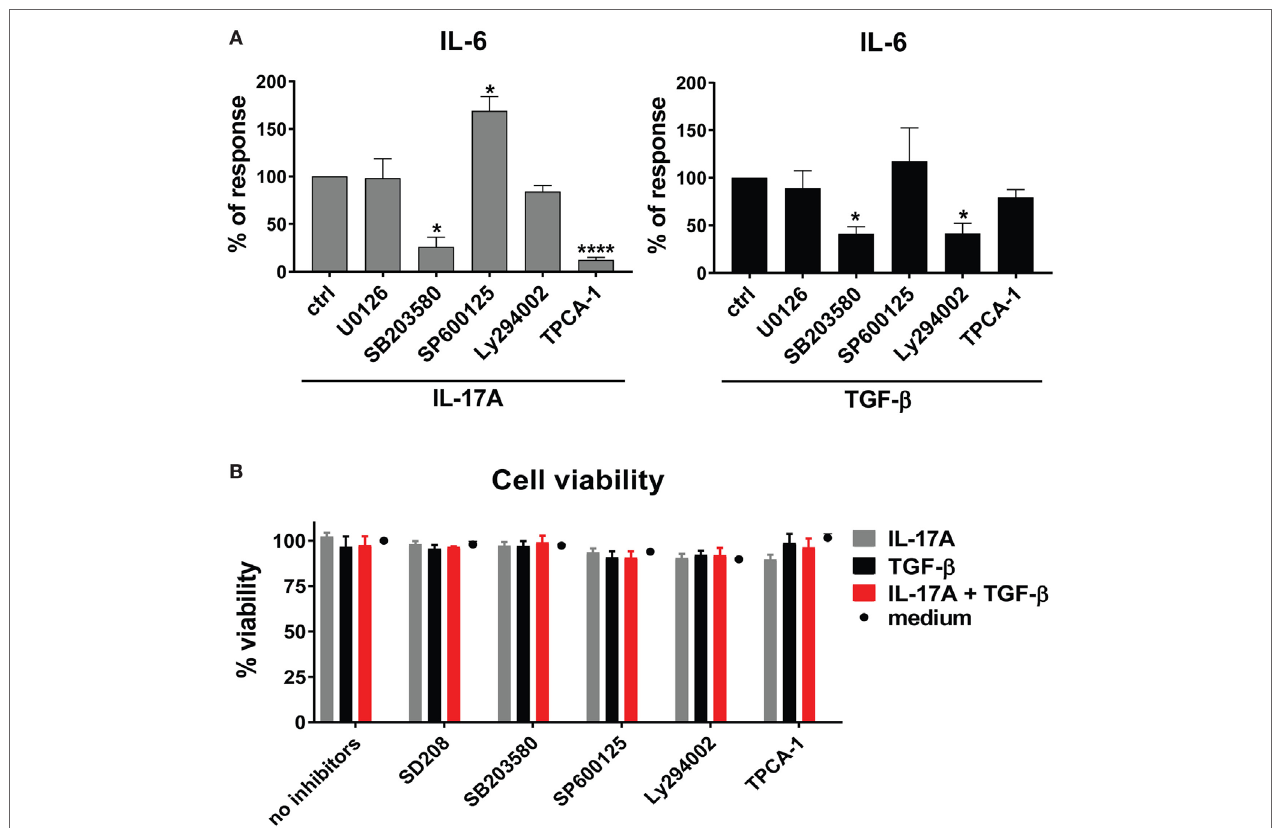
FigUre 3 | Shared and private signaling pathways are preferentially used by IL-17A and TGF- β to induce IL-6. Healthy donors fibroblasts were treated with optimal doses of inhibitors (20 µM U0126, 20 µM SB203580, 10 µM SP600125, 10 µM Ly294002, or 0.37 µM TPCA-1) or vehicle for 1 h prior to the addition of IL-17A (25 ng/ml) or TGF- β (2.5 ng/ml) and cultured for an additional 48 h, in triplicates. (a) IL-6 levels in SN were assessed by ELISA. Results are shown as the percentage of IL-6 production induced by IL-17A or TGF- β in the absence of inhibitors (levels of IL-6 were: 22.8 ± 3.3 pg/ml for IL-17A and 8.8 ± 3.9 pg/ml for TGF- β ). Bars represent the mean + SEM of three experiments. Significant differences versus control were assessed by paired t -test: * P < 0.05, **** P < 0.001. (B) . Fibroblast viability was assessed by EZ4U and found > 90% for all culture